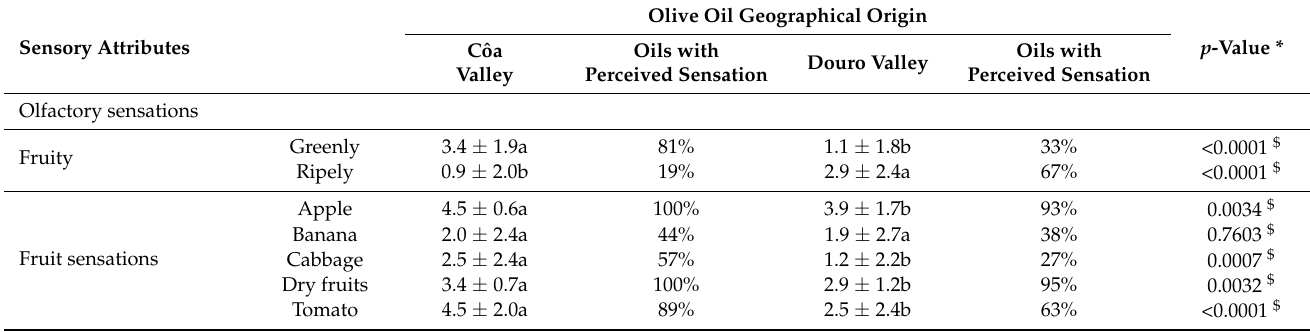
Table 2. Intensities (in an unstructured scale from not perceived (0) to maximum intensity (10)) of olfactory, gustatory, and global sensations (mean ± standard deviation; percentage of oils with the perceived sensation) of olive oils from the C ô a (36 oils) and Douro (31 oils)